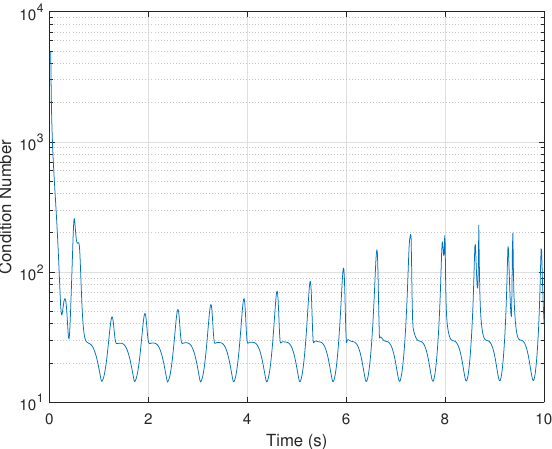
Figure 4. Lie Derivative-based observability analysis: condition number of observability matrix.